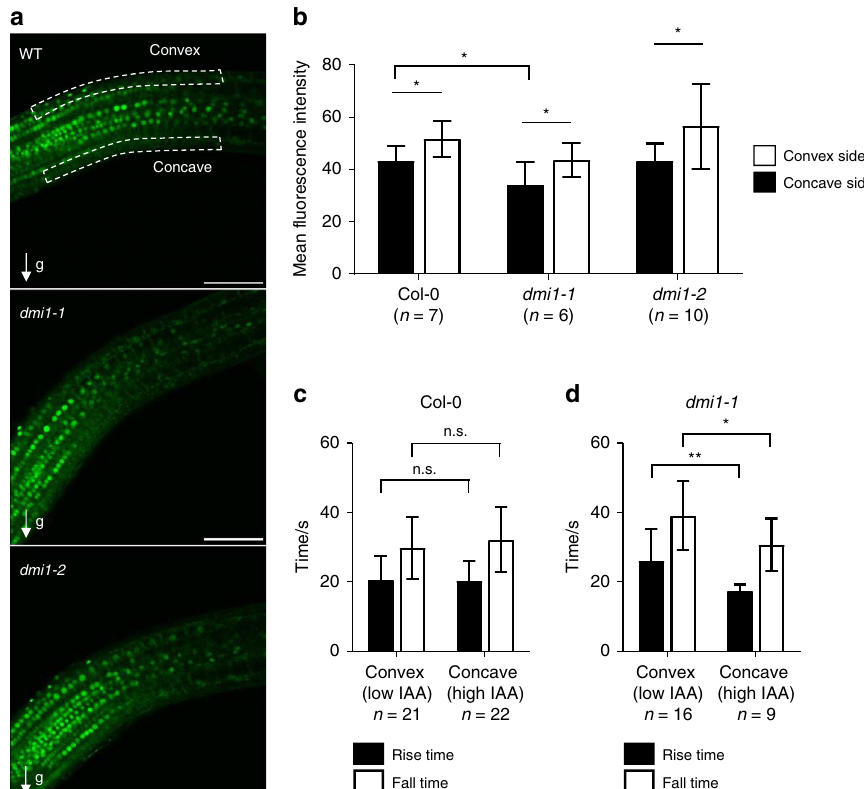
Fig. 4 Analyses of auxin abundance and calcium spikes in the concave and convex side of bent roots. a Representative images of bent roots of Col-0, dmi1- 1 , and dmi1-2 plants expressing DII-VENUS 6 days after germination and 90 min after a gravity stimulus (g) of 90 degrees. Dashed lines delimit area used for quanti fi cation in the concave (high auxin) and convex (low auxin) sides. Scale bars represent 100 µ m. b Mean fl uorescence intensity of the DII-VENUS signals in Col-0, dmi1-1 , and dmi1-2 . Intensity was averaged across the concave and convex delimited areas (marked in a ). The total area was the same for each plant. Values are means± s.d. The number of plants imaged (sample size) is indicated ( n ). c , d Rise and fall time in seconds (s) of calcium spikes recorded in the convex (low auxin) and concave (high auxin) areas in wild-type ( c ) and dmi1-1 ( d ) roots. Values are means± s.d. Sample size is indicated (number of spikes, n ). n.s. not signi fi cant, * p < 0.05, ** p < 0.01 (two-tailed t test with a prior F -test for homoscedasticity). The data represent two biological